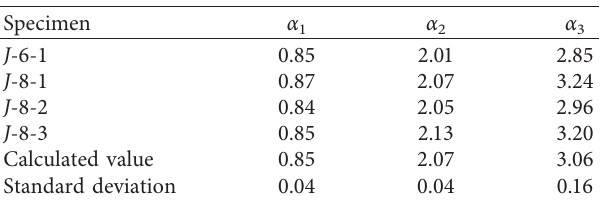
Table 6: Coefficients of rotation in the simplified trilinear skeleton curve.